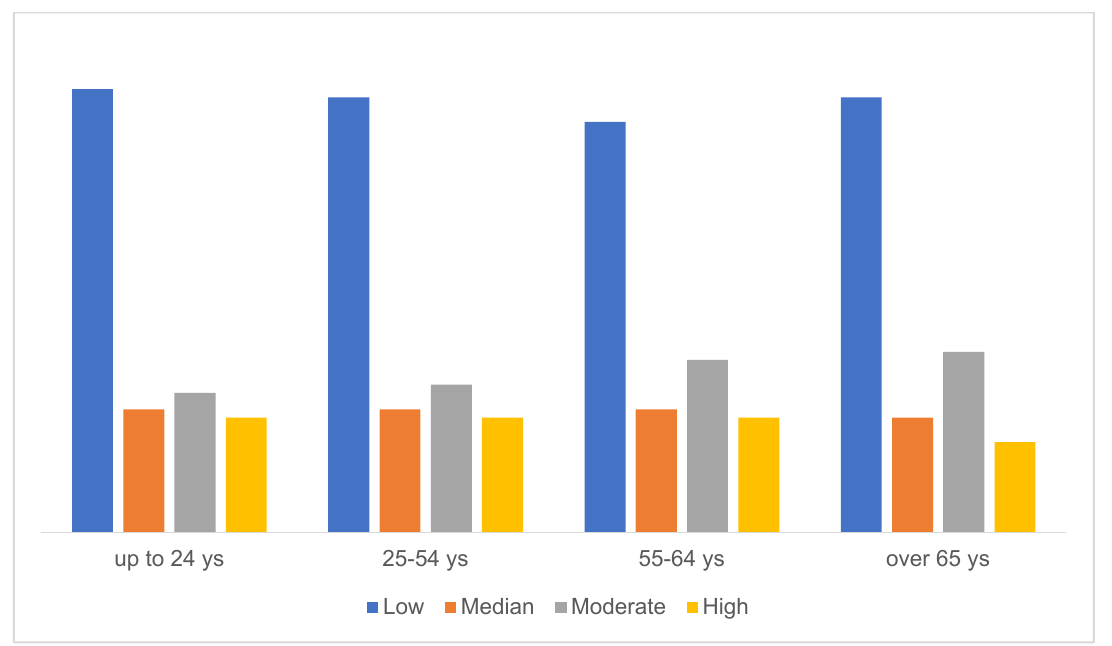
Figure 2. Levels of resilience according to the age group ( n = 20,270). Table 2. Differences among groups in the levels of resilience.